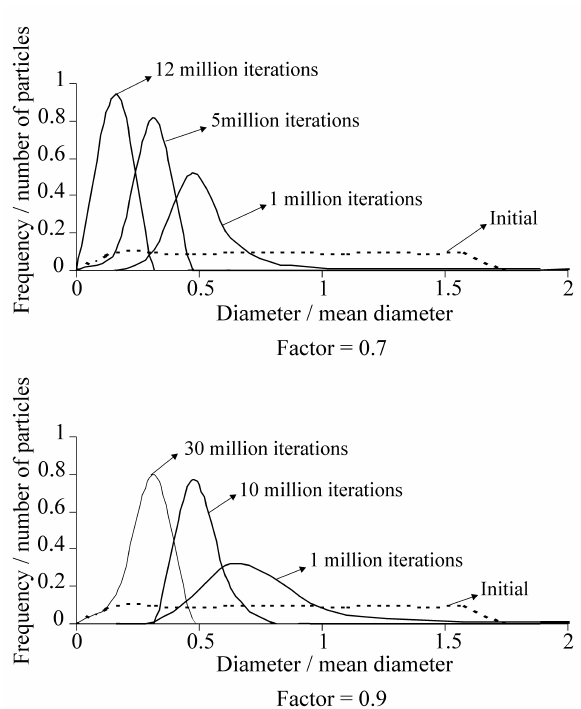
Figure 3. The action of w surface energy available to power w